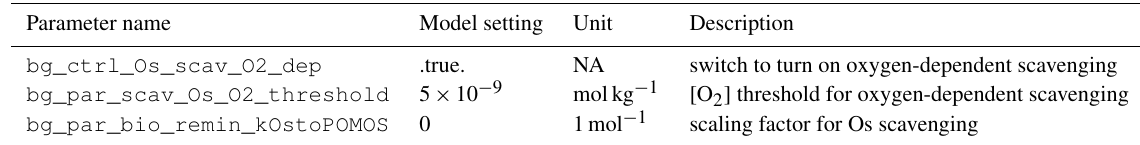
Table A1. Model parameters setting Os scavenging under sub-oxic